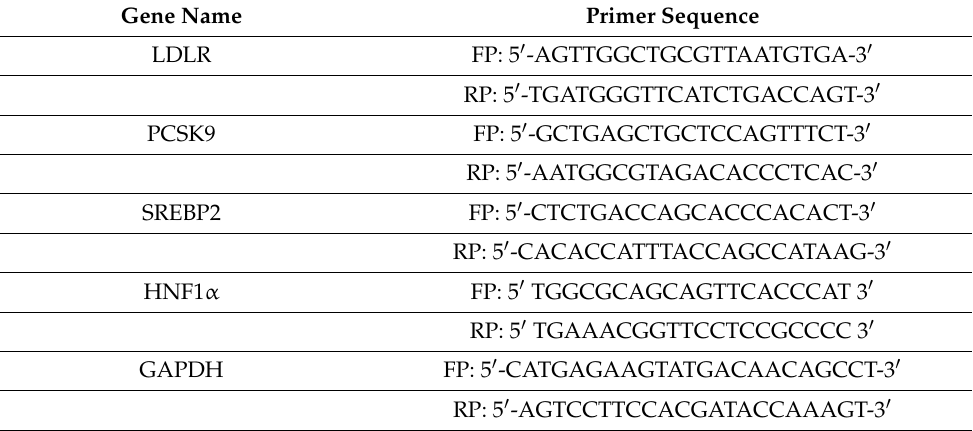
Table 1. Primer sequences used for